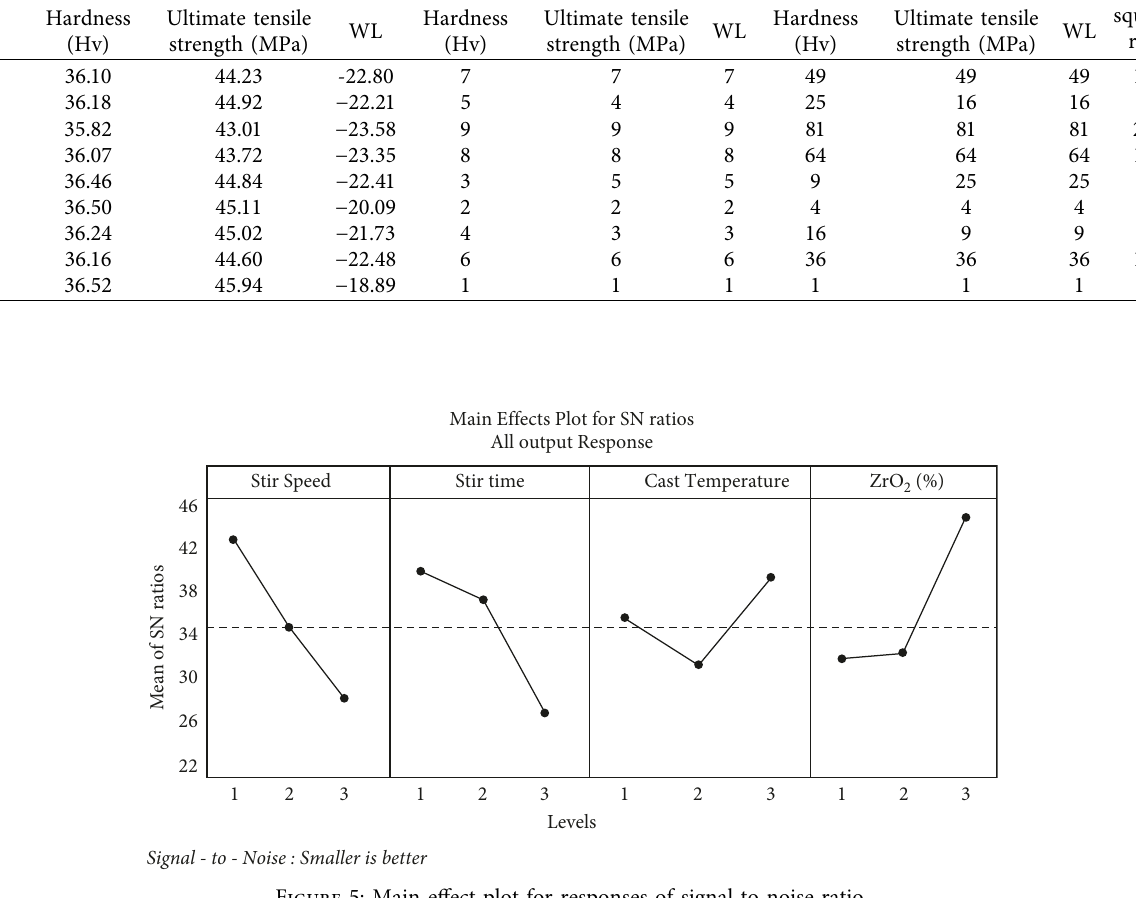
Table 4: Super ranking concept: stir-casting progression result summary. Trial.